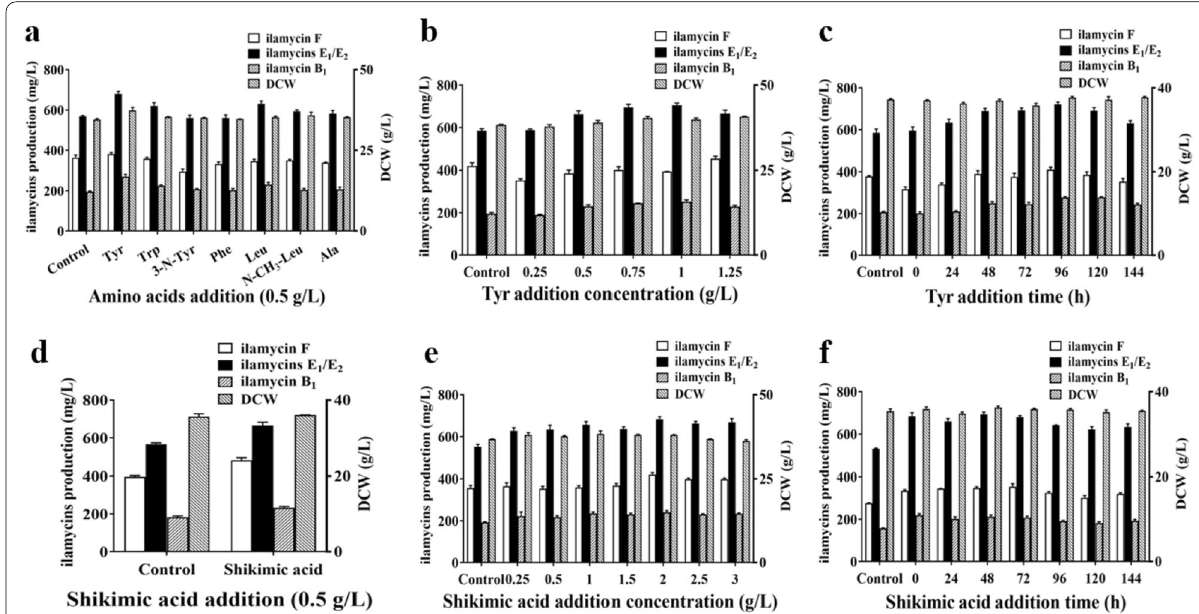
Fig. 6 Effect of amino acids addition ( a ), Tyr addition concentration ( b ), Tyr addition time ( c ), shikimic acid addition ( d ), shikimic acid addition concentration ( e ), and shikimic acid addition time ( f ) on DCW and ilamycins